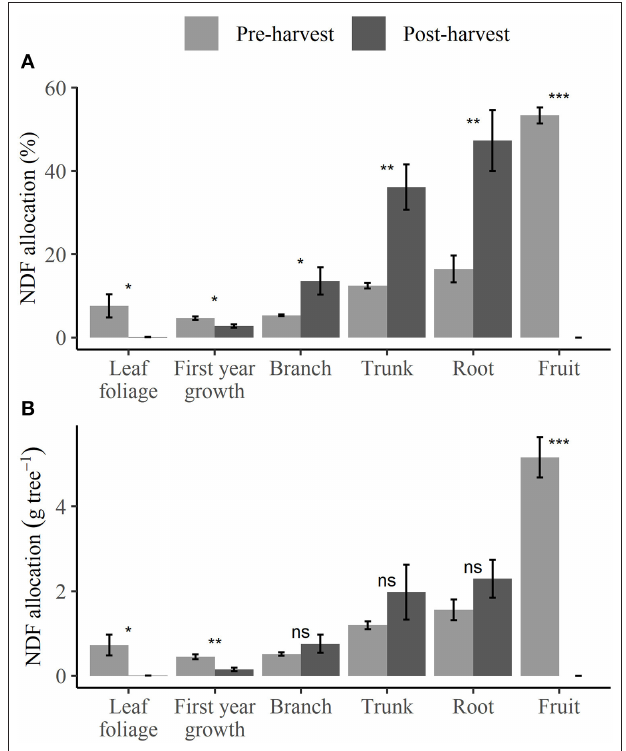
FIGURE 5 | Proportion (A) and total amount (B) of nitrogen derived from fertilizer (NDF) allocated into different organs for N-treated trees destructively harvested at dormancy of the 2017–2018 season under different N application treatments. Error bars represent ± SEM, n = 4. For each organ, notation indicating the extent of difference between treatments from unpaired two-sample t -test: ns p > 0.05; * p < 0.05; ** p < 0.01; *** p <